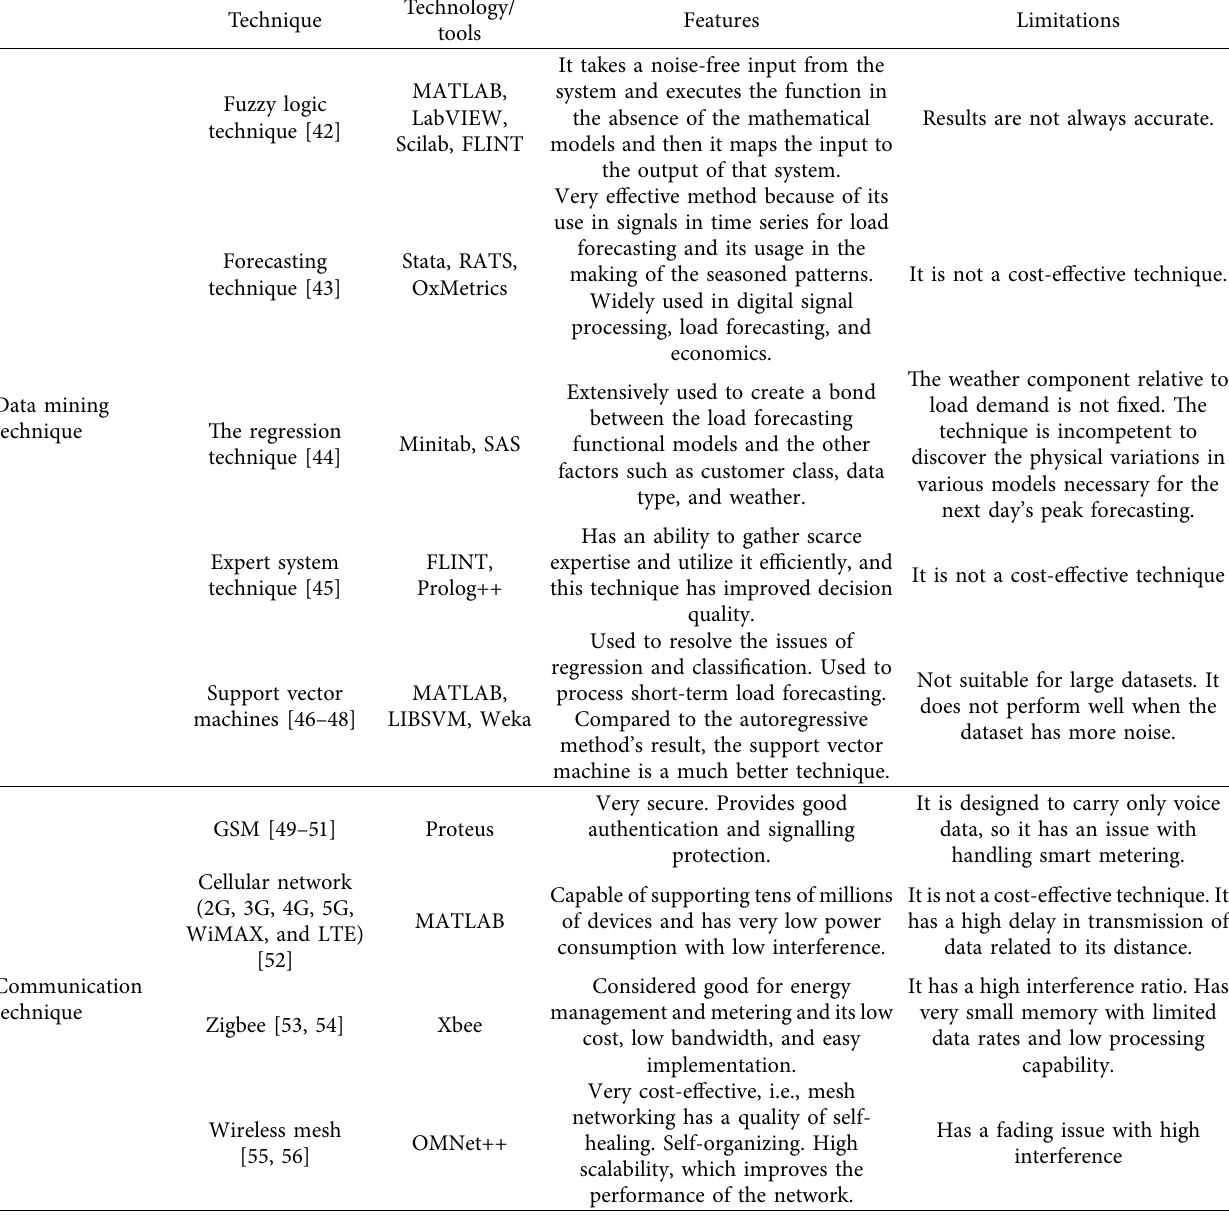
Table 2: Comparative analysis of smart grid